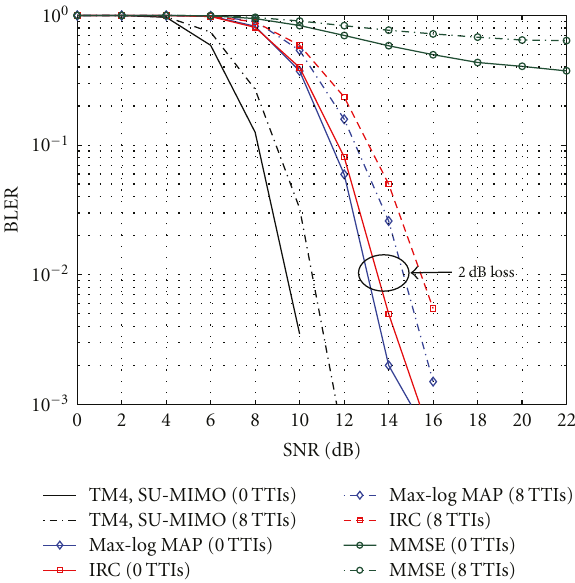
Figure 5: BLER versus SNR (dB) performance of MU-MIMO receivers for 16QAM modulation, urban micro, 30 km/h, LS- channel estimation, and feedback delay.